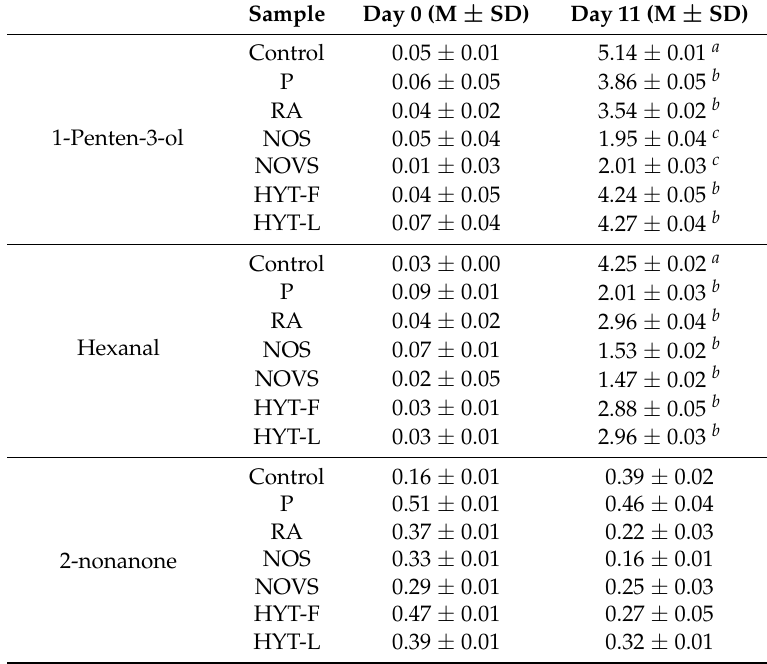
Table 4. Average values and standard deviations of organic compounds (mg/g) in fish patties stored for 11 days, under retail